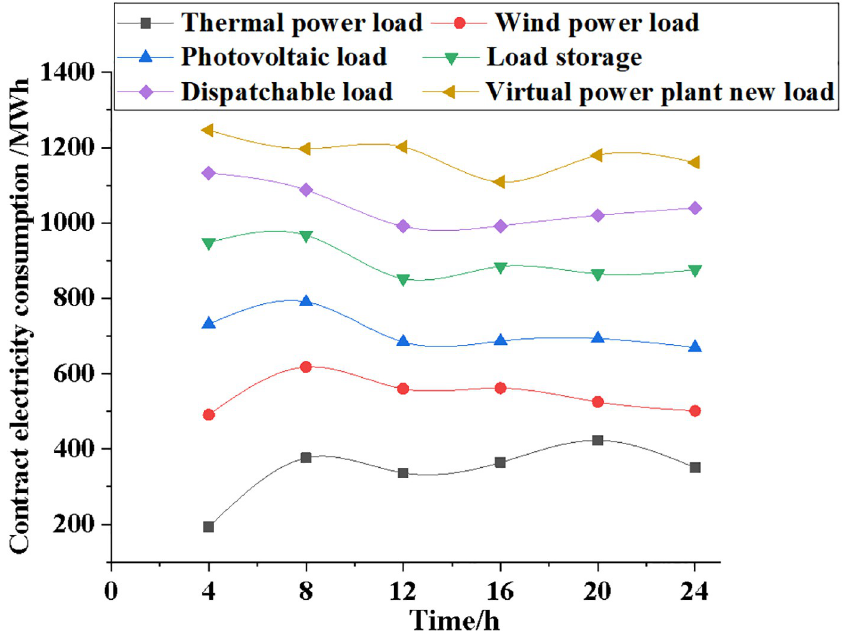
Fig 9. Changes and comparison of contract power data for different power load